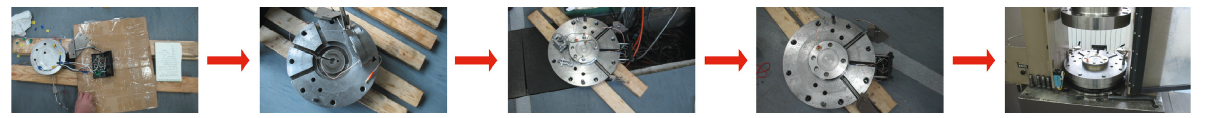
Figure 11: Test and installation.